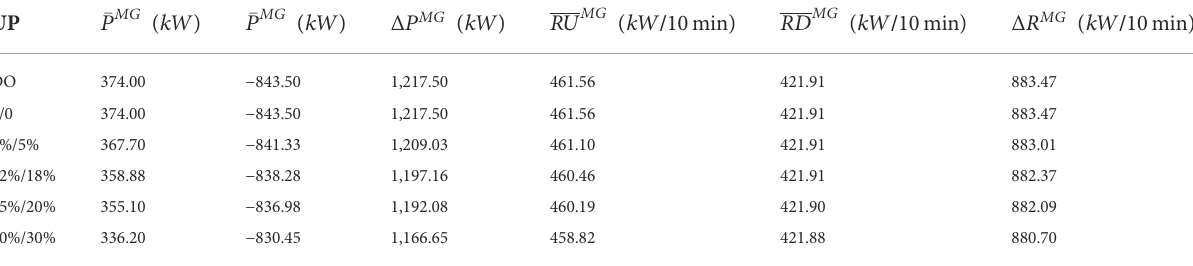
TABLE 4 Results of MG-FPs with different risk preferences in con fi guration case 1.